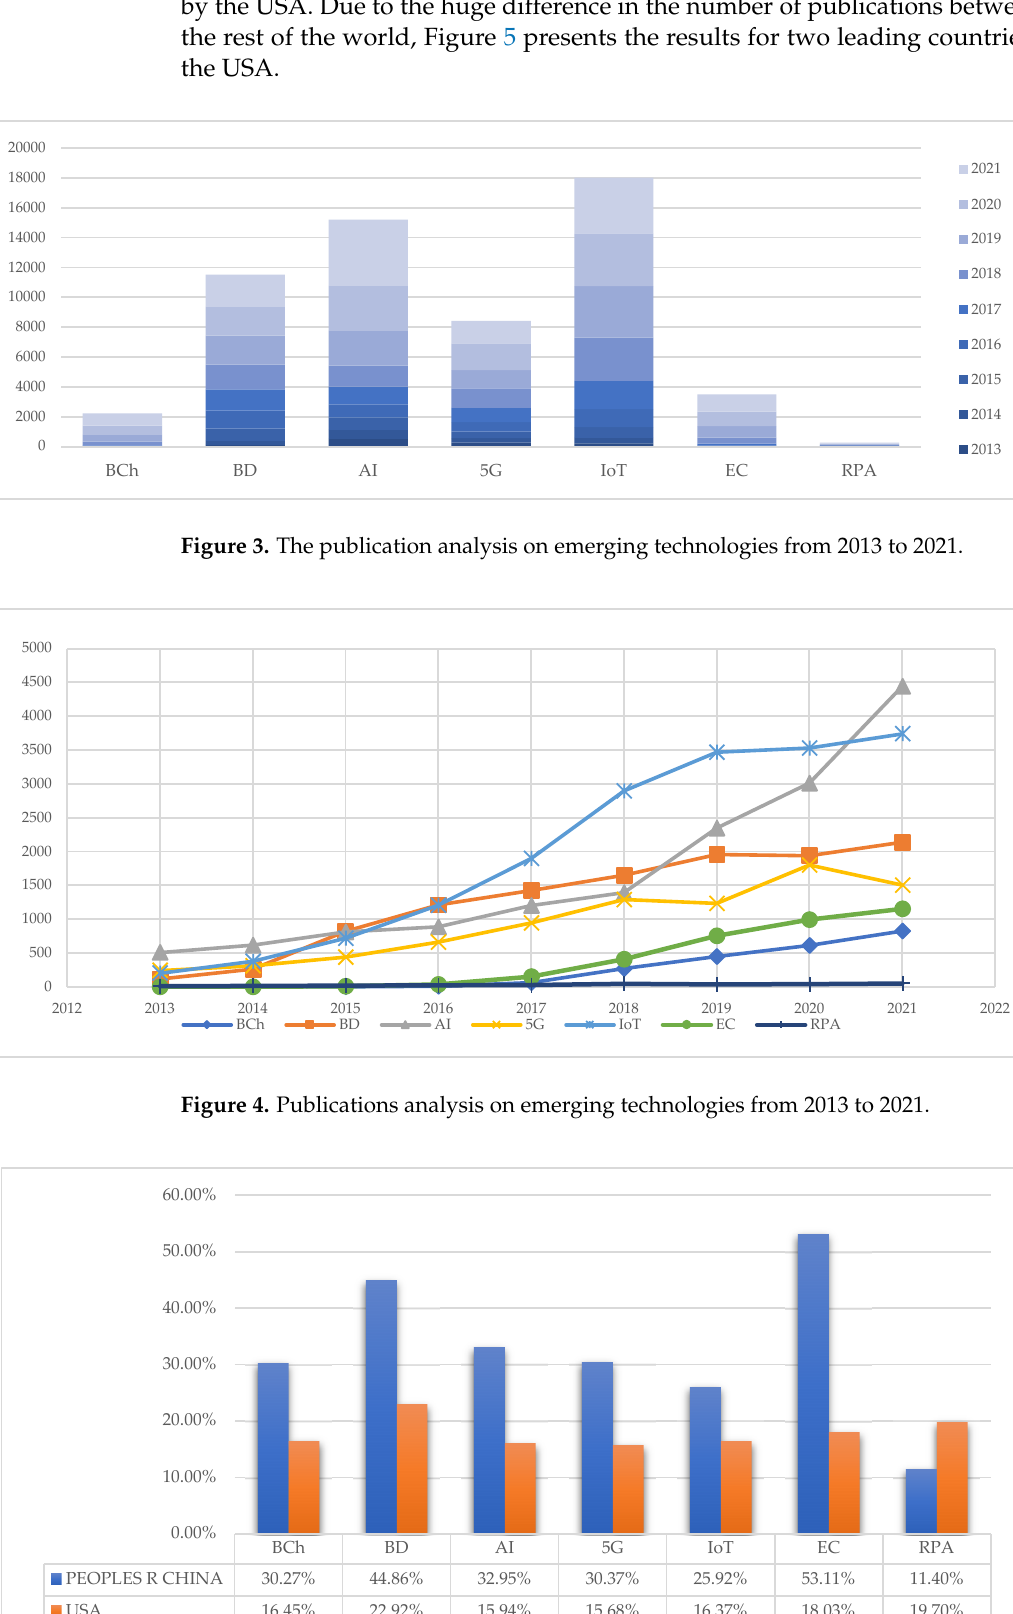
Figure 5. Publications analysis by countries.